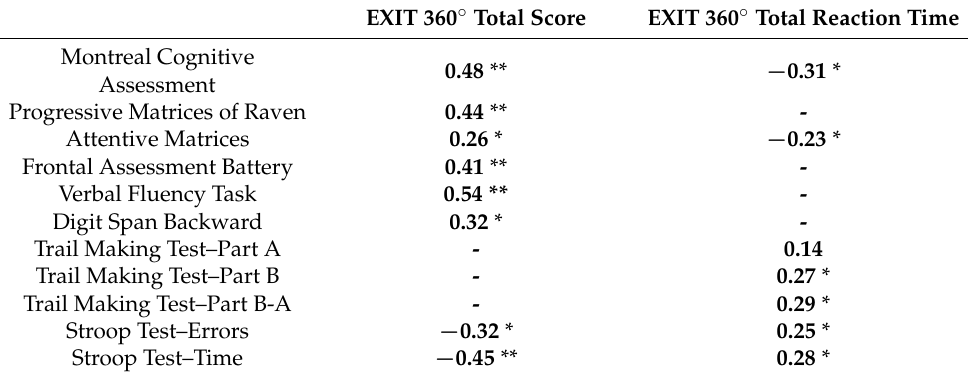
Table 5. Correlation between EXIT 360 ◦ scores and neuropsychological assessment. In bold, statisti- cally significant scores. * p < 0.05; ** p < 0.001. EXIT 360 ◦ Total Score EXIT 360 ◦ Total Reaction Time